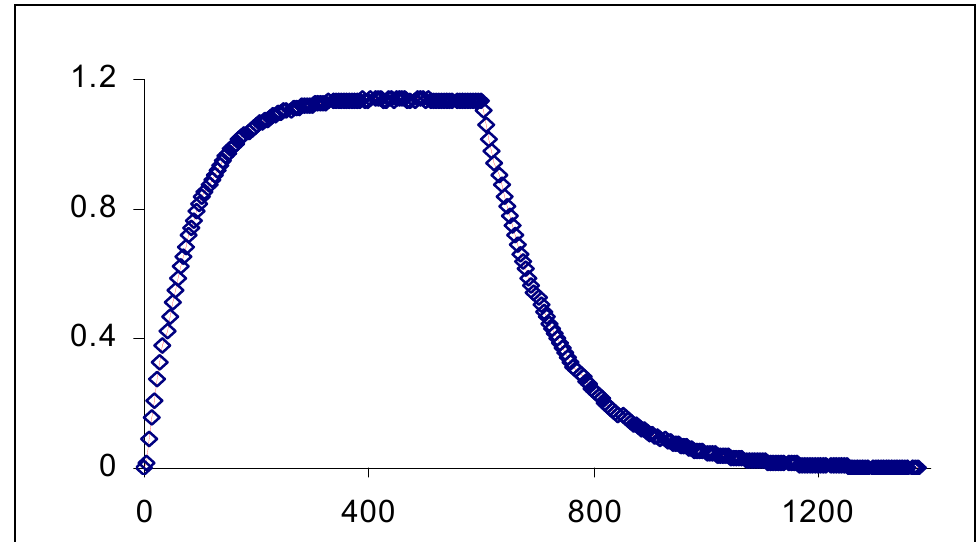
Figure 7. Kinetic traces of the photocolouring and the thermal fading reactions of -BIPS (Scheme 6) in ethyl acetate (plots represent Absorbance vs. Time (in s)). The NO 2 experimental data (squares) are fitted by model Eqs. 21a and 20b (solid lines). = 5.83 10 -5 M, λ = 339 nm, λ = 580 nm [reprinted from Ref. 92 with T = 14 ˚ C, C 0 isos obs permission of the International Journal of Chemical